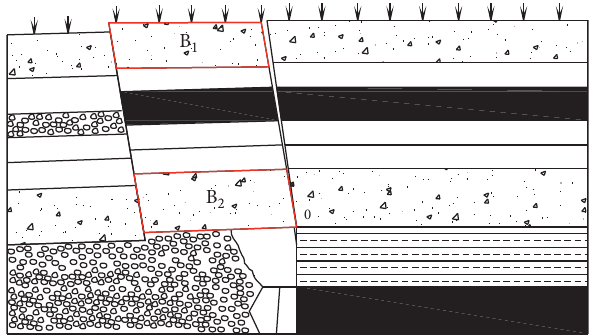
Figure 6: Fracture instability structure model of rock column in combination key